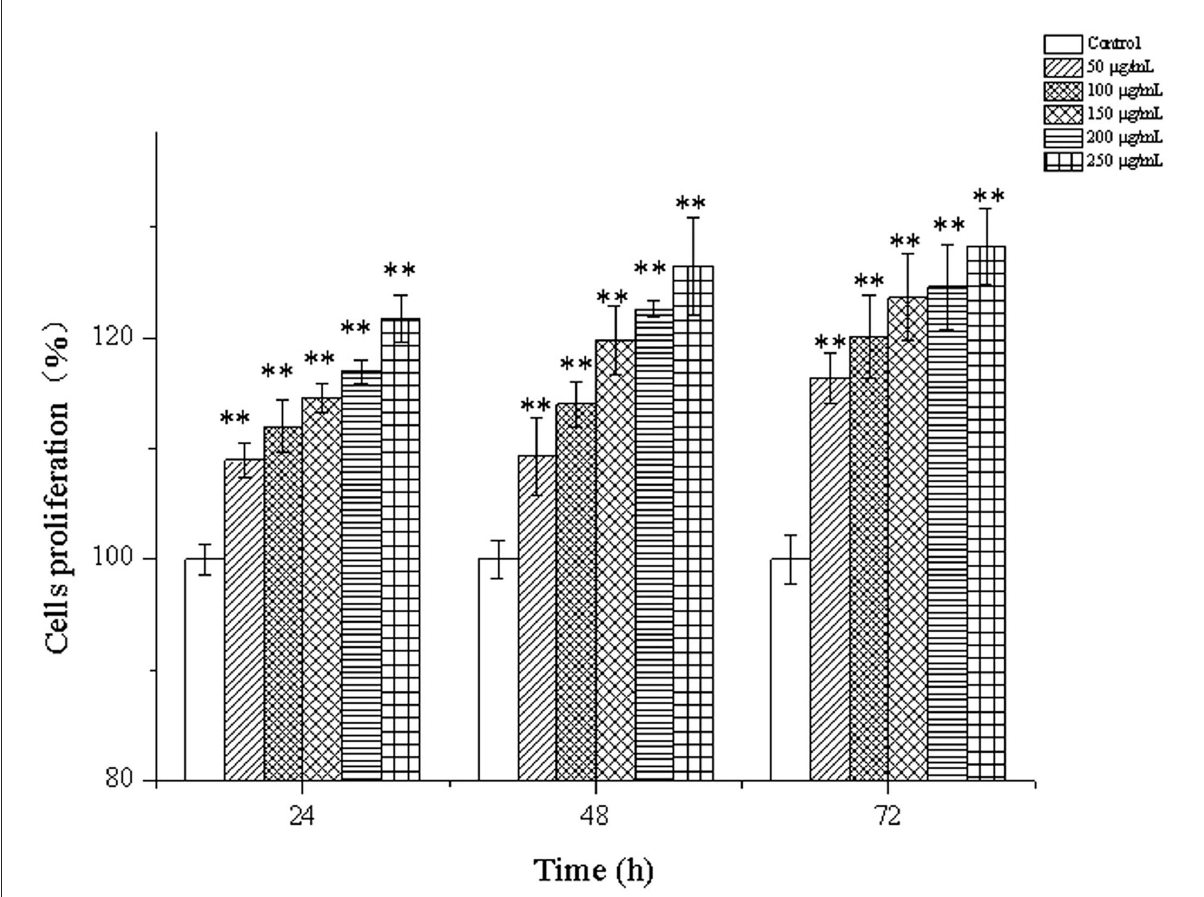
FIGURE4 Cells proliferation of MC3T3-E1 cells treated with CPP-Ca (50, 100, 150, 200, and 250 µ g/mL) at 24, 48, and 72h. * p < 0.05; ** p < 0.01, compared with the control